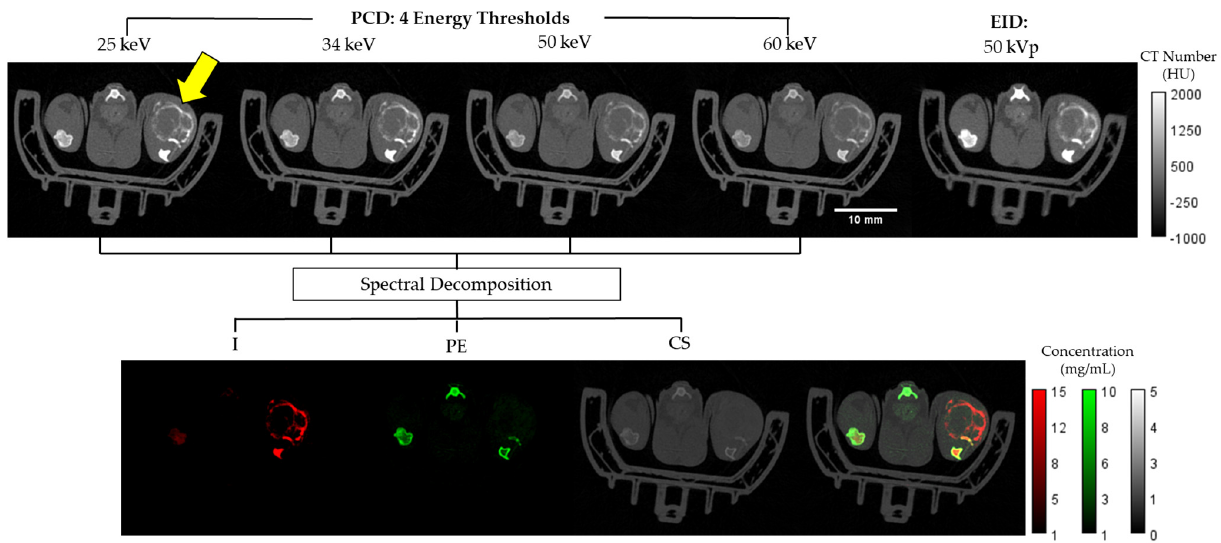
Figure 2. Axial slices from a Rag2 +/ − mouse. Shown at the top row are Hounsfield unit (HU)-normalized images from the four energy bins for the PCD and the EID CT. The bottom row shows the three material color-coded maps in mg/mL (I, PE, CS) as well as a composite representation of the three materials overlaid. The tumor region is identified by the yellow arrow within the upper left PCD image.